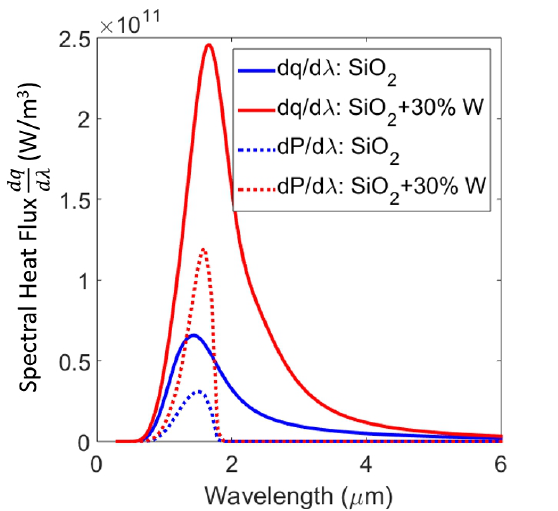
Figure 4. Predicted spectral density of output power (dashed lines) from GaSb PV cell for emitter with pure SiO 2 thin film and SiO 2 with 30% of W nanoparticles for a separation of 100 nm compared with corresponding spectral heat fluxes (solid lines).